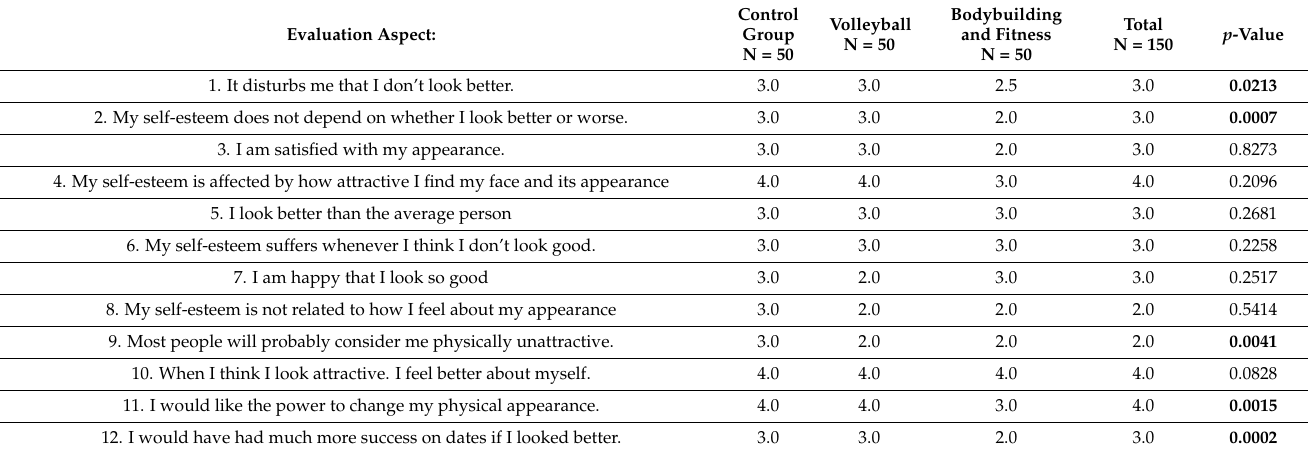
Table 5. Assessment of self-esteem and self-confidence related to the appearance of one’s own body using a questionnaire in the opinion of female respondents (median).